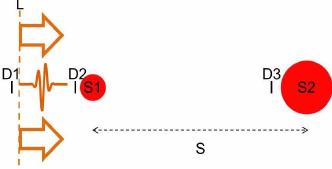
Figure 2. Schematic illustration of an A-scan showing the locations of optical axis and reference plane. The reference plane has zero optical path difference (OPD) with the reference mirror in OCT setup.